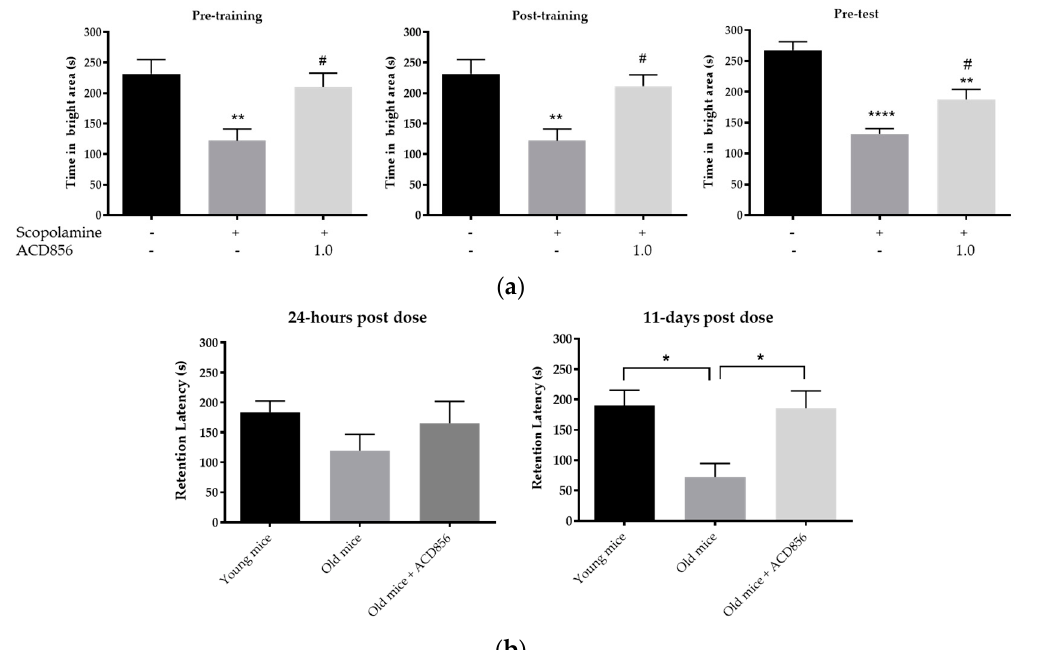
Figure 8. ACD856 improves the acquisition, consolidation, and retrieval of memories. ( a ) Effects of ACD856 on acquisition, consolidation, or retrieval on scopolamine-induced amnesia in the passive avoidance model. The memory was assessed by measuring the total time that the animals spent in the bright compartment, the maximum being 300 s. Vehicle or ACD856 were administered as a single dose by subcutaneous (s.c.) injection (4 mL/kg body weight) at different timepoints in relation to the training session. On the day of training (Day 1), ACD856 or vehicle was administered either 60 min prior to training (pre-training, left graph) or 5 min post-training (post-training, middle graph). When evaluating the effects on the retrieval of memories on day 2, either vehicle or ACD856 was administered 30 min before the test session (pre-test). On the day of training, scopolamine at 0.3 mg/kg, or vehicle was administered subcutaneously 30 min prior to training. ** p < 0.01 or **** p < 0.0001 for scopolamine- vs. the vehicle-treated group (black bars). # p < 0.05 for compound and scopolamine-treated animals vs. the scopolamine-treated group. ( b ) ACD856 reversed aged-induced memory impairment at 24-h and 11 days post-dose. Left panel, the old mice displayed lower retention latency than the young mice, but it was not statistically significant. A single injection of ACD856 at a dose of 3 mg/kg induced a slight increase in retention latency in comparison to vehicle-treated old mice. Right panel, the retention latency was significantly higher in control young mice and the ACD856-treated group with old animals in comparison to the old control group when tested 11 days after the first retention test (* p < 0.05).